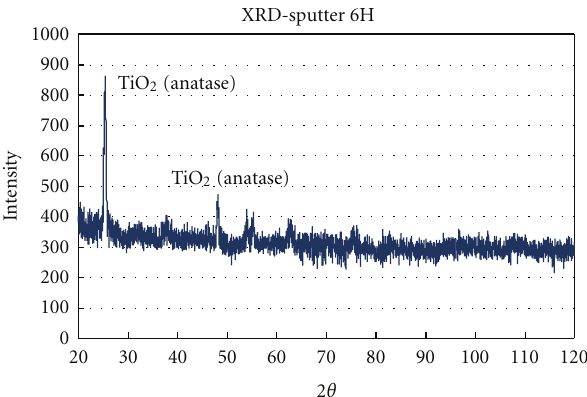
Figure 2: XRD spectrum of TiO 2 prepared by CVD method.